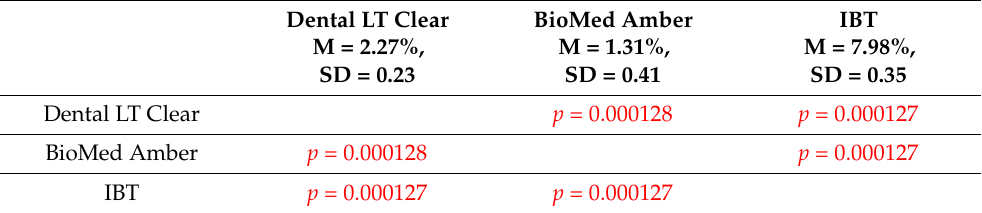
Table 10. Nominal strain differences in the Tukey highly significant difference test (M—mean; SD—standard deviation; the statistical significance for p < 0.05 was presented in red).